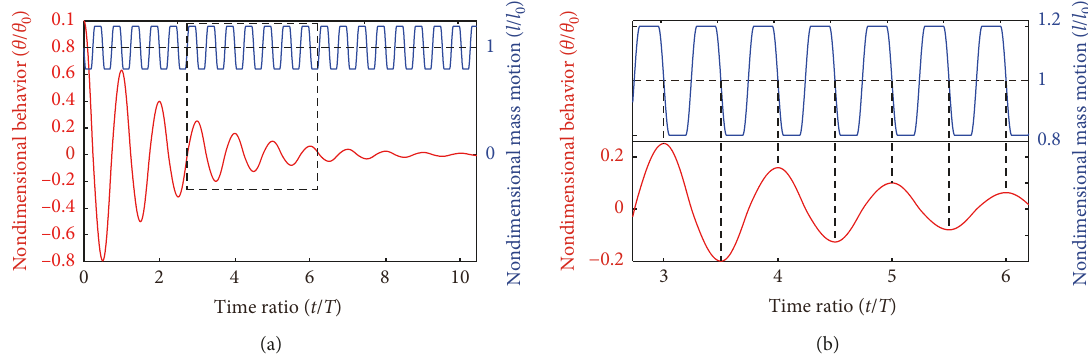
Figure 11: Synchronous motion. (a) θ 0 (cid:30) 0.1rad, the effects of the motion distance 4/15, the effect of the initial amplitude θ 0 on the exact damping ratio ζ e . damping ratio ζ e ; (b) ∆ L / L (cid:30)